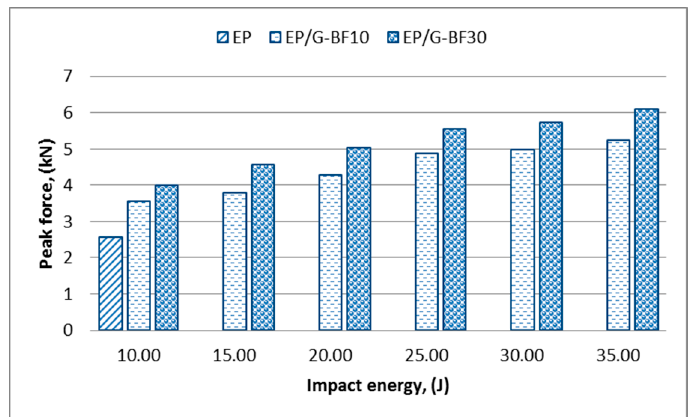
Figure 4. Variation of the peak force for the EP and EP / G-BF composites in the second range of impact energy levels.